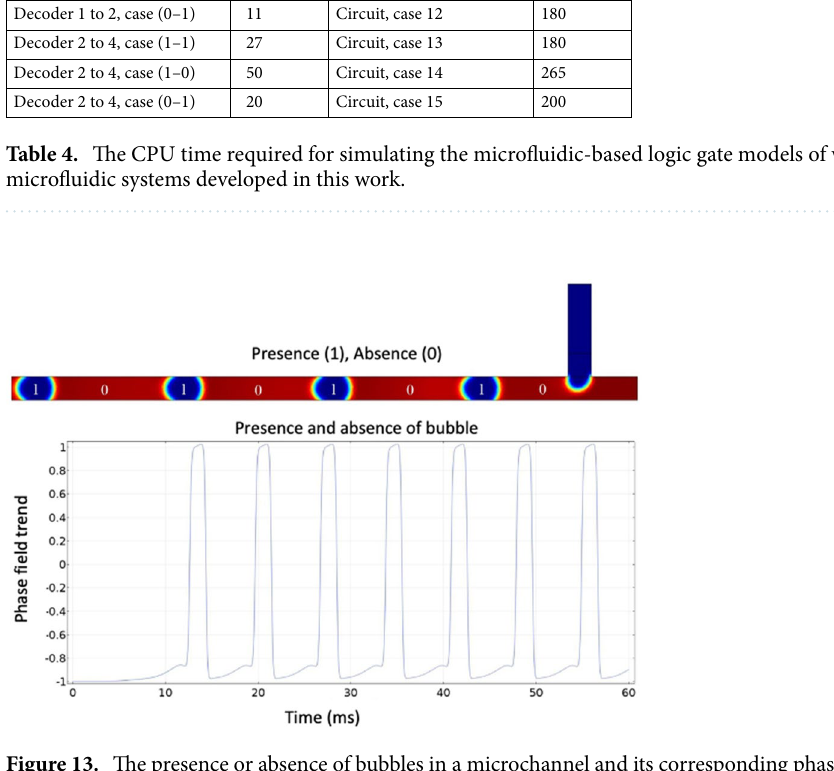
Figure 13. The presence or absence of bubbles in a microchannel and its corresponding phase-field trend. Each bubble represents a bit of data, wherein the presence of bubble = 1 and absence of bubble = 0. The phase-field trend shows the presence of a bubble when it reaches the probe point (output port).